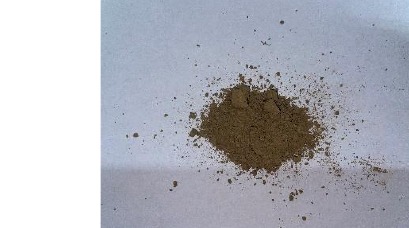
Figure 1. Geographical location diagram of the study area.